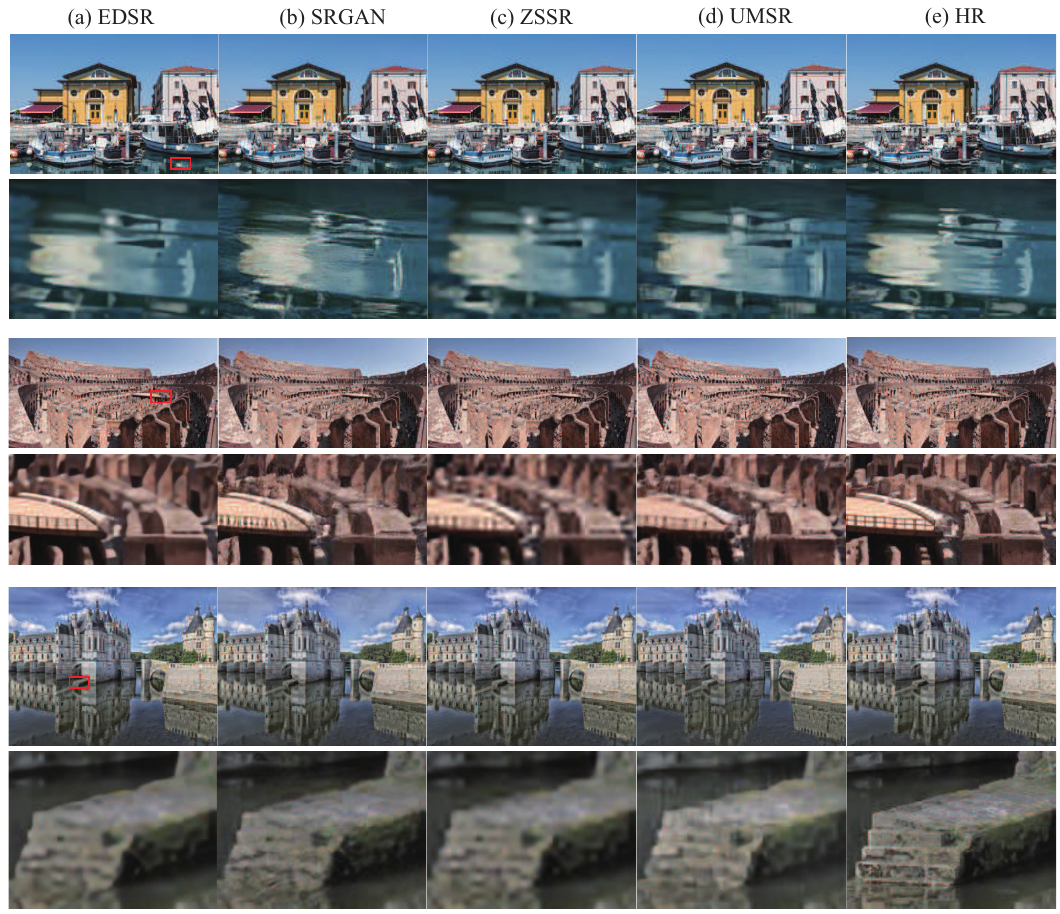
Figure 7. Comparison on supervised and unsupervised methods. ( a )EDSR; ( b )SRGAN; ( c )ZSSR; ( d )UMSR; ( e